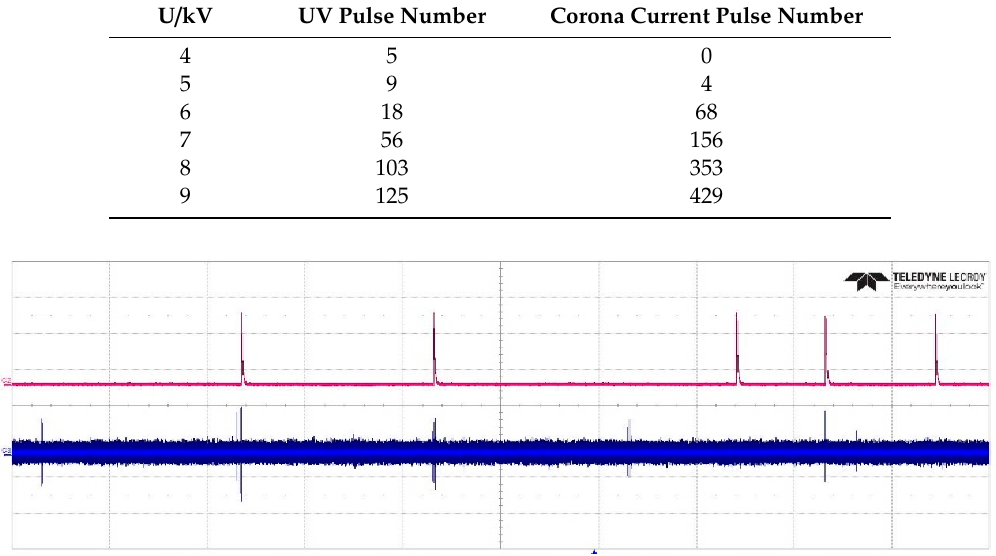
Figure 17. Phase contrast of a UV pulse and the corona current pulse.